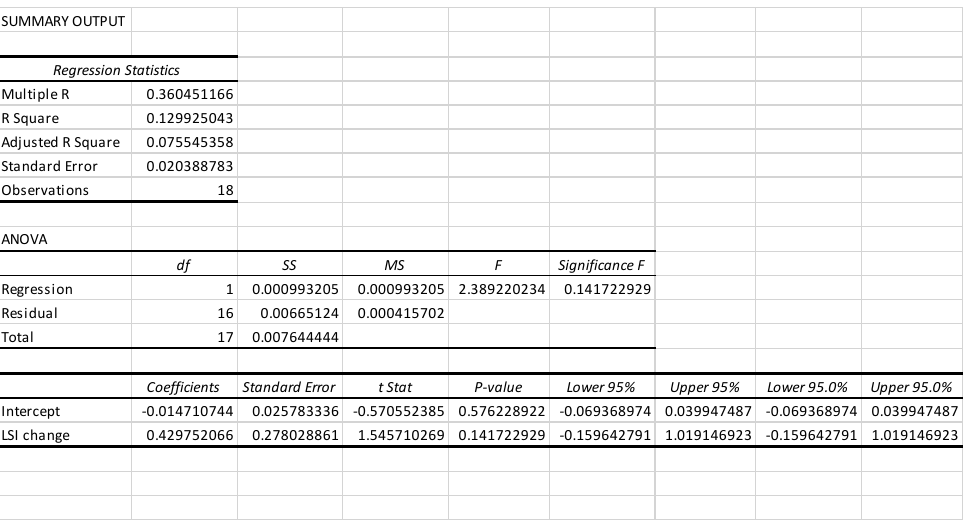
Figure 6. Correlation of LSI change and CD/TD